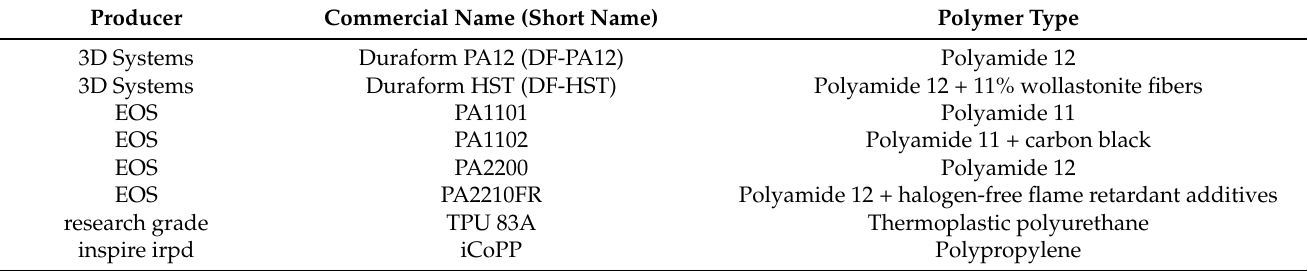
Table 1. Materials list.